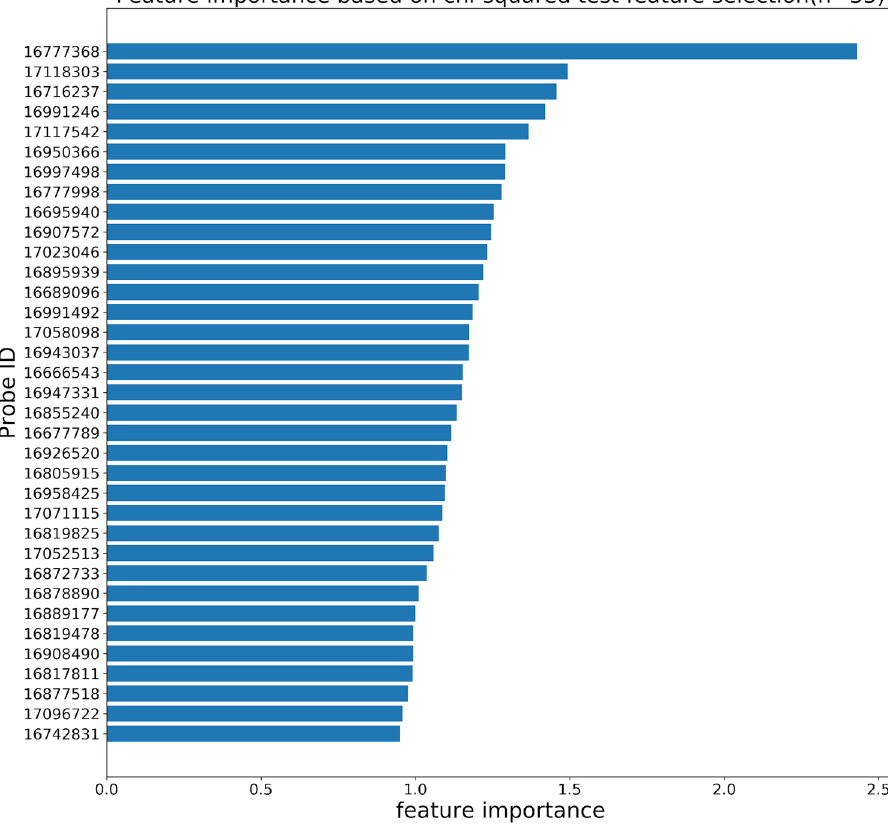
Figure 4. The average feature importance of the top 35 selected probes/genes. See more detailed annotation information in Supplementary Table